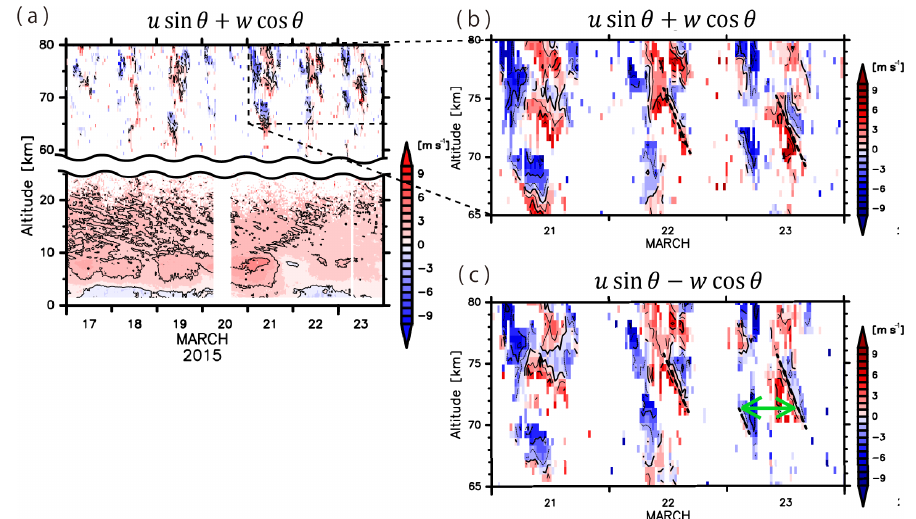
Figure 2. Time–altitude cross sections of eastward line-of-sight velocity components observed by the PANSY radar at Syowa Station (a) for the period from 17 to 23 March 2015, (b) for the period from 21 to 23 March 2015 and (c) opposite of westward line-of-sight velocity components observed by the PANSY radar for the period from 21 to 23 March 2015. The dashed line in (b) and (c) denotes phase lines with the downward phase velocity of 0.3ms − 1 . The green arrows in (c) denotes the wave period of the disturbance. The contour intervals are 2ms − 1 .